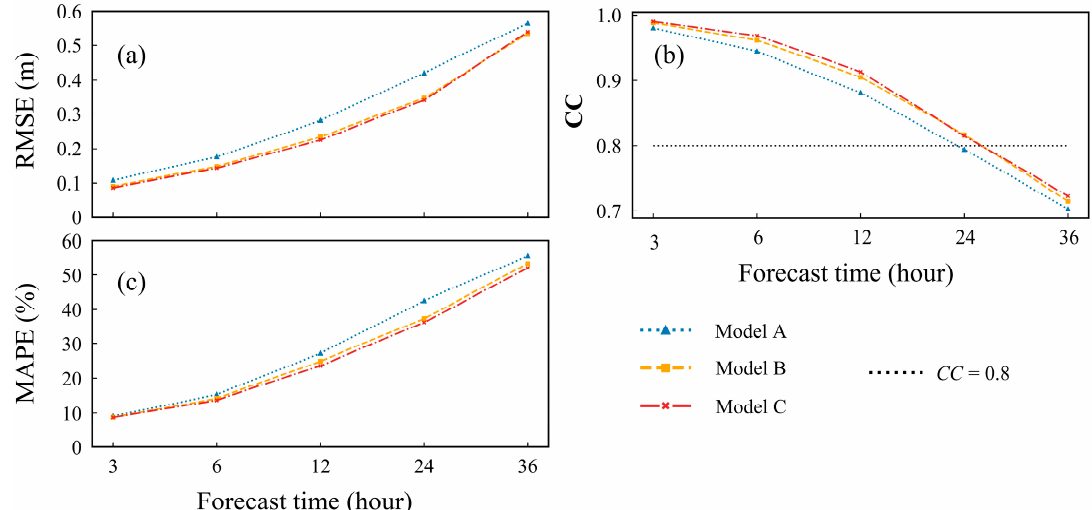
Figure 5. Variation of error indices for Model A, B, and C in the test set for 3-, 6-, 12-, 24-, and 36-h SWH forecasting.